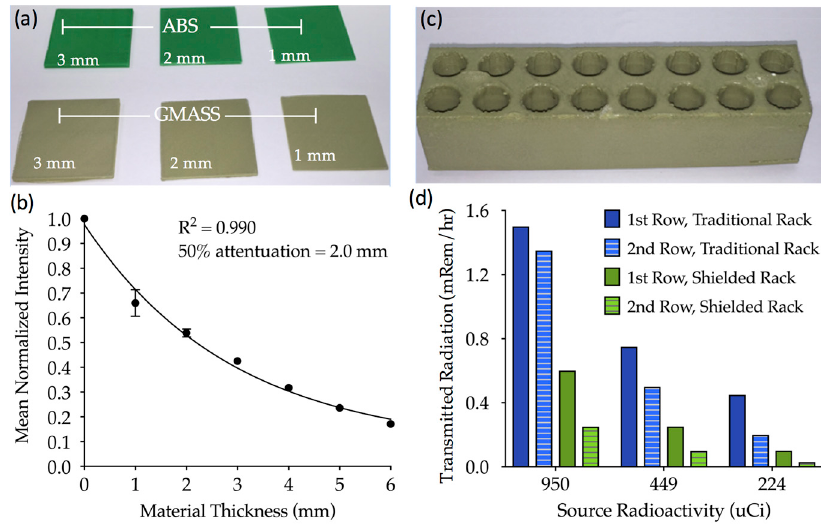
Figure 3. 3D-printed GMASS attenuation of radiation from 99m Tc emission sources: ( a ) 3D-printed sheets made from ABS and GMASS filaments with thickness ranging from 1 to 3 mm that were stacked to make sheets with thickness between 1 and 6 mm; ( b ) Plot of mean normalized radiation intensity transmitted through GMASS sheets of varying thickness, normalized to ABS sheets of the same thickness. Each sheet thickness was subject to multiple radiation sources with distinct intensities, and an average normalized radiation intensity was calculated (black line); ( c ) 3D-printed test tube rack made from GMASS filament; Plot of transmitted radiation through the shielded GMASS tube rack and a traditional tube rack from 99m Tc emission sources with varying initial radioactivity levels.